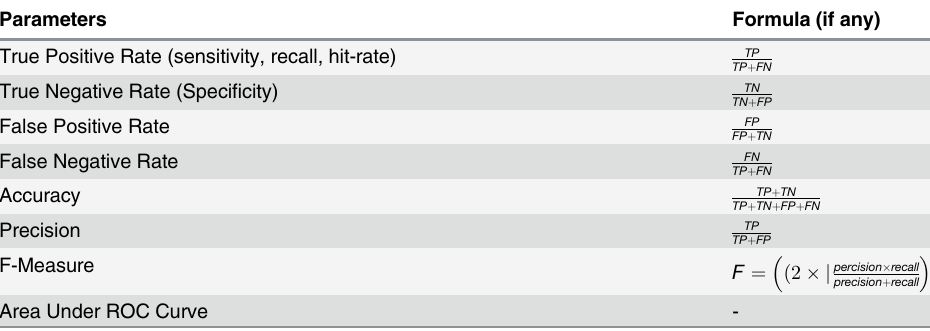
Table 4. Observed Classification